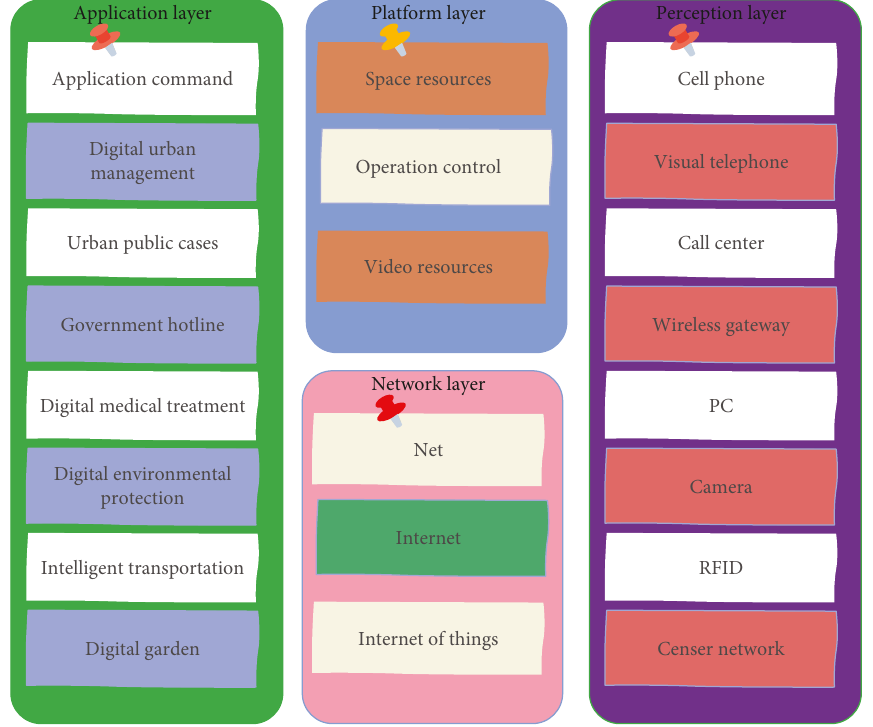
Figure 8: Smart city management platform.